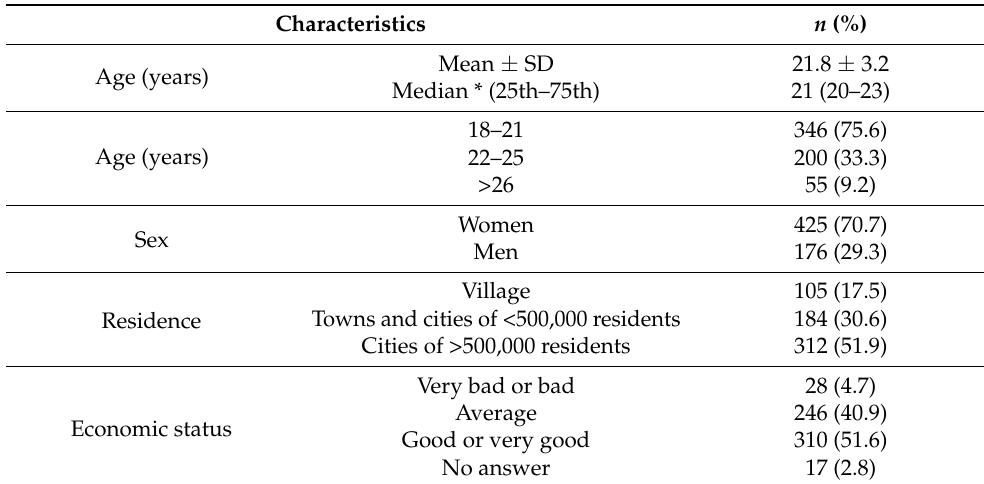
Table 2. Characteristics of the participants of the study ( n =